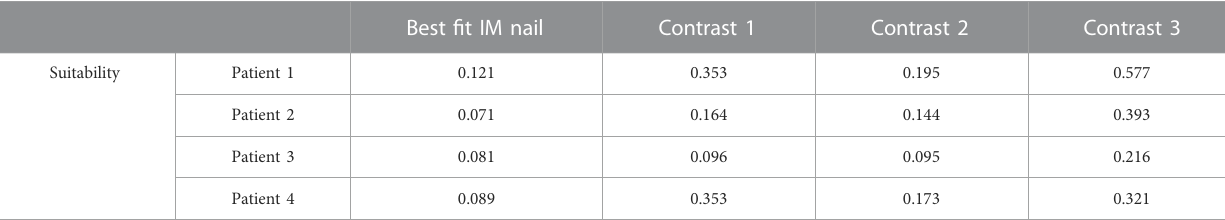
TABLE 2 Suitability of different intramedullary nails for 4